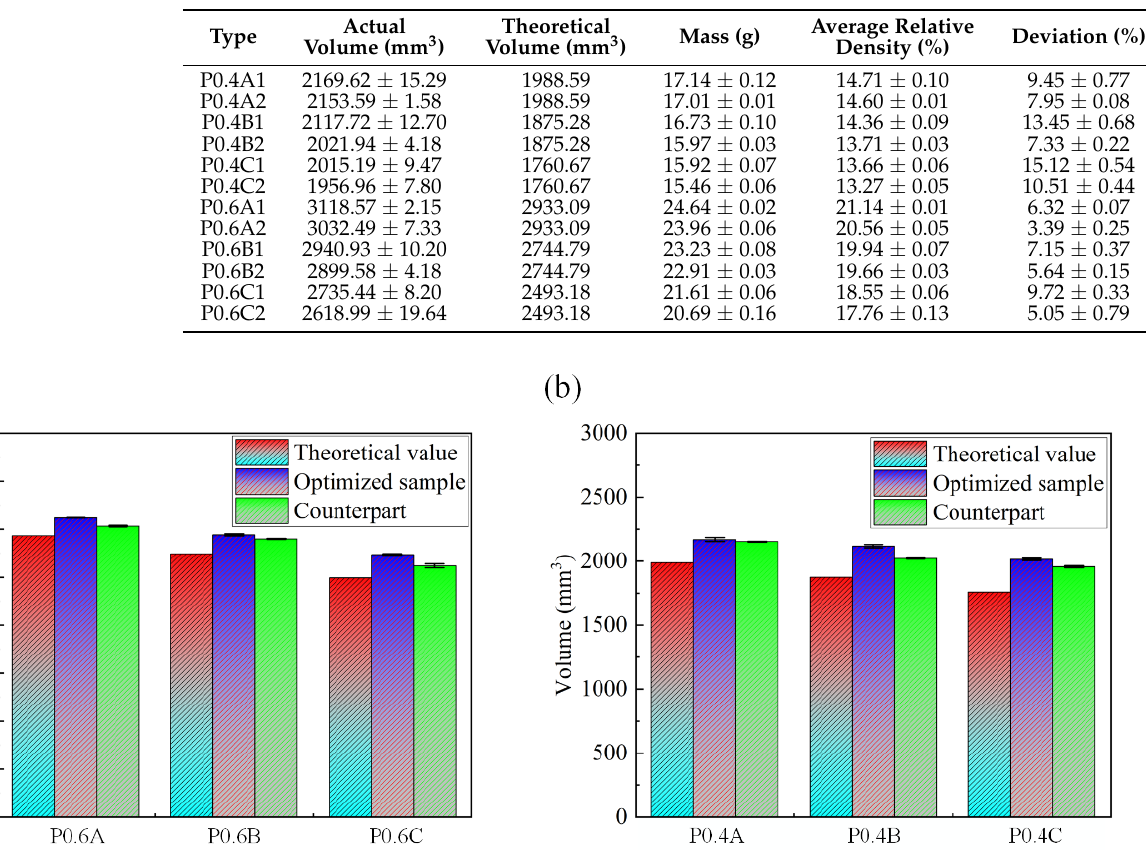
Figure 4. Comparison between the theoretical volume and actual volume of ( a ) P0.6 and ( b ) P0.4. Figure 5 shows the SEM images of the outer surface and inner surface of an optimized P-TPMS scaffold. In general, no macro-defects (cracks, pores, and deformation) are ob- served, showing good printability of the samples. The staircase effect can be seen along the building direction and some particles are adhered to the surface. Additionally, it can be noted that excess powders are adhered to the surface of the sample, especially for the downward-facing surface and lateral surface, resulting in the increased thicknesses. As for the bottom surface, a notably rough morphology can be observed due to a large amount of released heat during the solidification of the printed layers, resulting in the adjacent powder melting and sticking to the surface [21]. As for the lateral surface, there are metal powders hanging on the surface because there is no support at the sharp corners of the edges during the manufacturing process. When comparing the inner and outer surfaces, it can be found that the inner surface is rougher due to the topology optimization. The reason behind this is that the sheet thickness of the optimized samples is constantly changing compared to the samples with a uniform sheet thickness, while the diameter of the laser beam is constant during the layer-by-layer processing